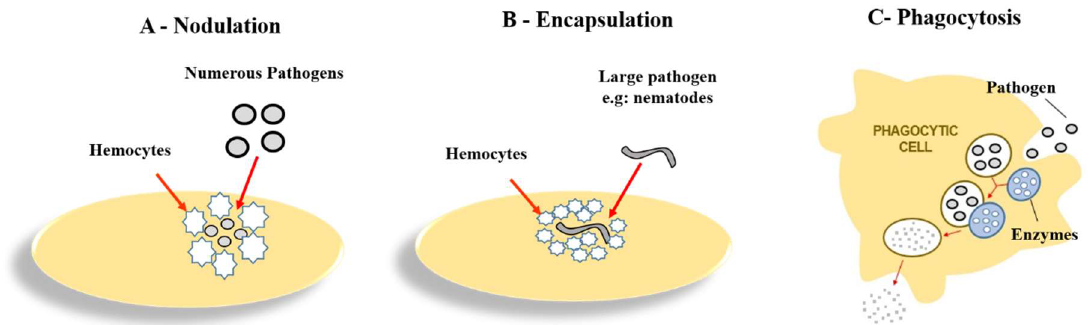
Figure 2. Different defense mechanisms employed by hemocytes in Galleria mellonella : ( A ) nodulation: hemocytes form a layer of cells around a group of microorganisms, this process occurs in the presence of a large number of microorganisms [59]; ( B ) encapsulation: plasmocytes and granulocytes form a capsule around large pathogens such as protozoa, nematodes and parasitic insect eggs or larvae [76–78]; ( C ) phagocytosis: plasmocytes and granulocytes produce enzymes to destroy the pathogen [1,80].